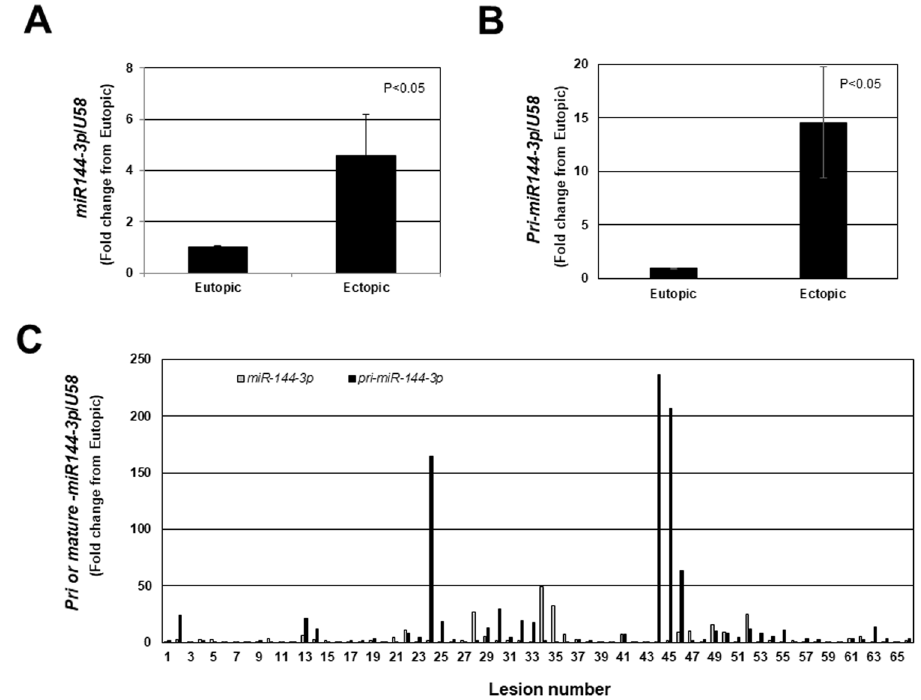
Figure 1. Mature miR-144-3p and pri- miR-144-3p average and individual lesion expression in human endometriotic lesion tissue. Matched endometriotic lesion and corresponding eutopic endometrial tissue was processed for RNA isolation and miR-144-3p ( A ) and pri-miR-144-3p ( B ) expression was determined by qRT- PCR as described under “Materials and Methods”. All data are displayed as the mean ± the standard error of the mean (SEM) and p-values are indicated for each assessment for eutopic endometrial samples. ( C ) Ratio (fold change from eutopic tissue expression) of mature miR-144-3p and pri- miR-144-3p in each individual lesion (N = 66). Data did not pass normality testing and were therefore analyzed using the non-parametric Mann- Whitney